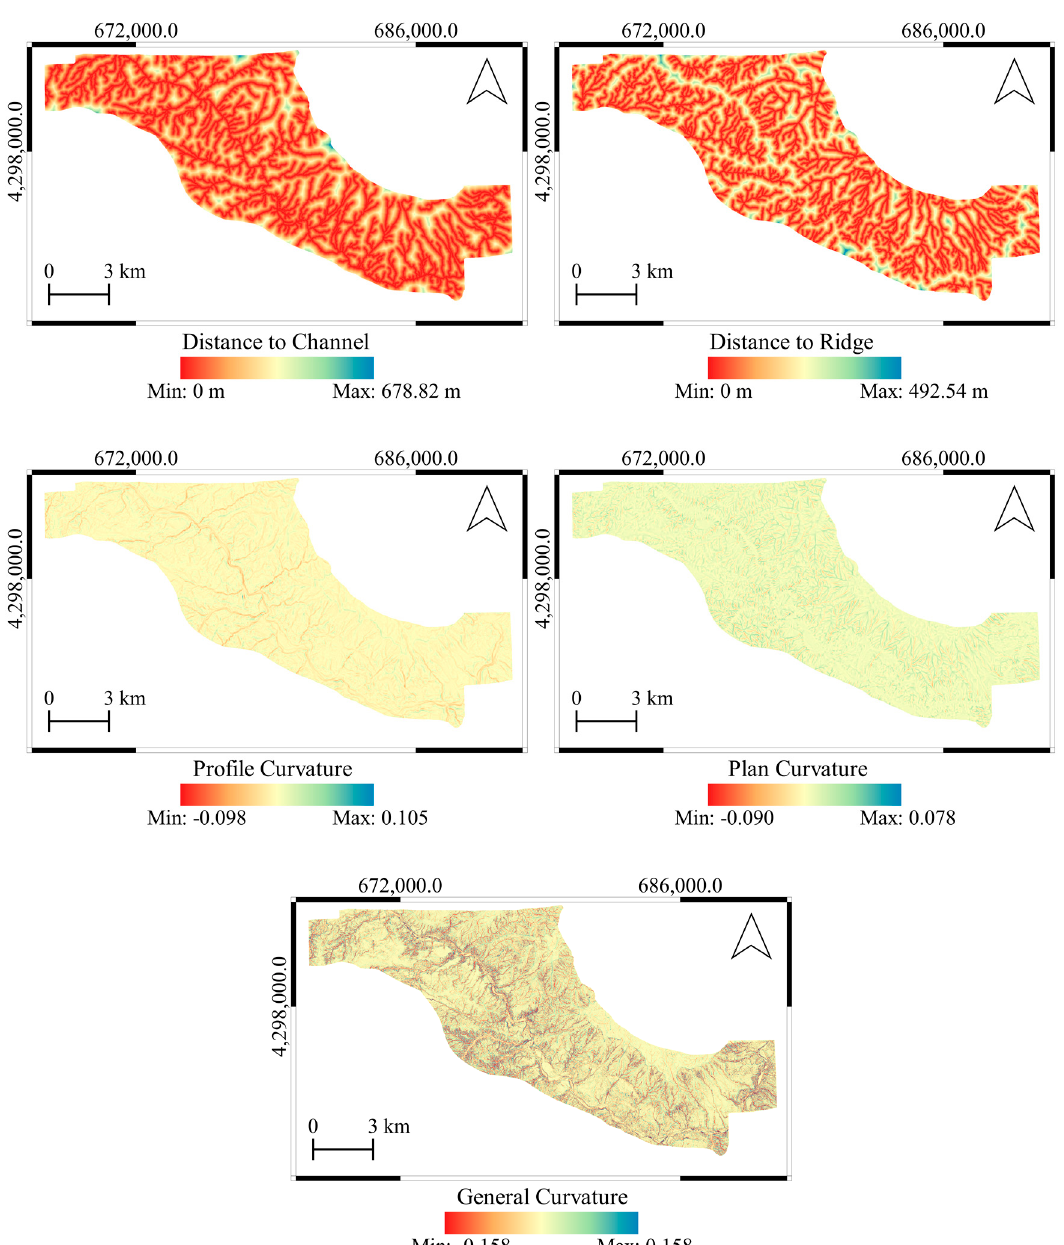
Figure 6. Distance maps to the channels and the ridges and the curvature (general, plan, and profile) parameters produced from 2012 DTM.